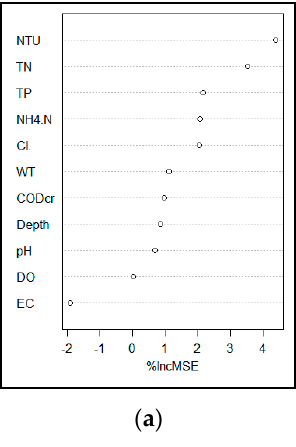
Figure 10. Environmental factors ranked in descending order of importance based on ( a ) %IncMSE and ( b ) major environmental drivers of phytoplankton abundance in